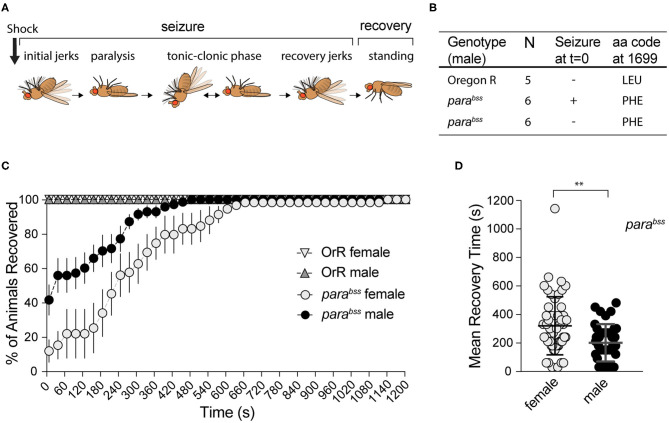
Effect of mechanical shock on seizuring behavior for female and male adult flies of parabss or OrR genetic background. (A) Schematic of the different phases of seizure after a mechanical shock [modified from Parker et al. (38)]. (B) Result of parabss gene sequencing in seizuring and non-seizuring males to test for the presence of the PHE mutation in position 1699 of the protein. All flies have the mutation. (C) Mechanical stimulation did not induce seizuring in OrR flies. parabss flies showed high proportion of seizuring at t = 0, the percentage of flies recovered increased as a function of time. The graph shows the mean % of flies recovered ± SEM [parabss females n = 6 (60 flies); parabss males n = 7(70 flies); OrR females n = 3 (30 flies); OrR males n = 3(30 flies)]. (D) Mean recovery time comparing males and females parabss (Mann−WhitneyU = 667, nfemales = 51, nmales = 41, P = 0.0034 two-tailed).